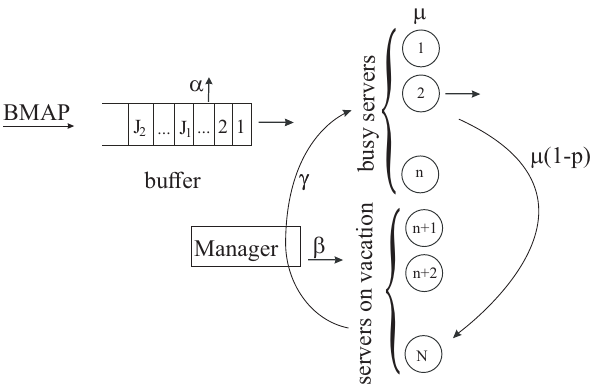
Figure 1. Structure of queuing system under